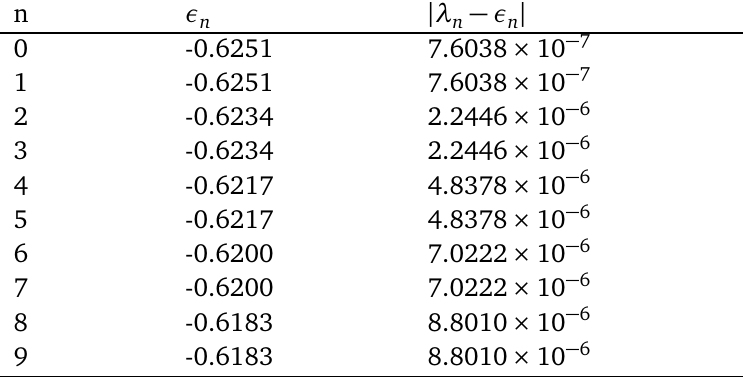
Figure 7: Scaled and shifted potential V for B = 2 and J = 1 , and the ground : = ˜ V N N / N for N = 60 . The single well is clearly state eigenfunction corresponding to J N + 1 visible. The ground state is plotted on the uniform grid corresponding to [ 0,1 ] , and also now the ground state eigenvector is normalized to 1 . Table 1. Eigenvalues and absolute differences ( J = 1, B = 1 /